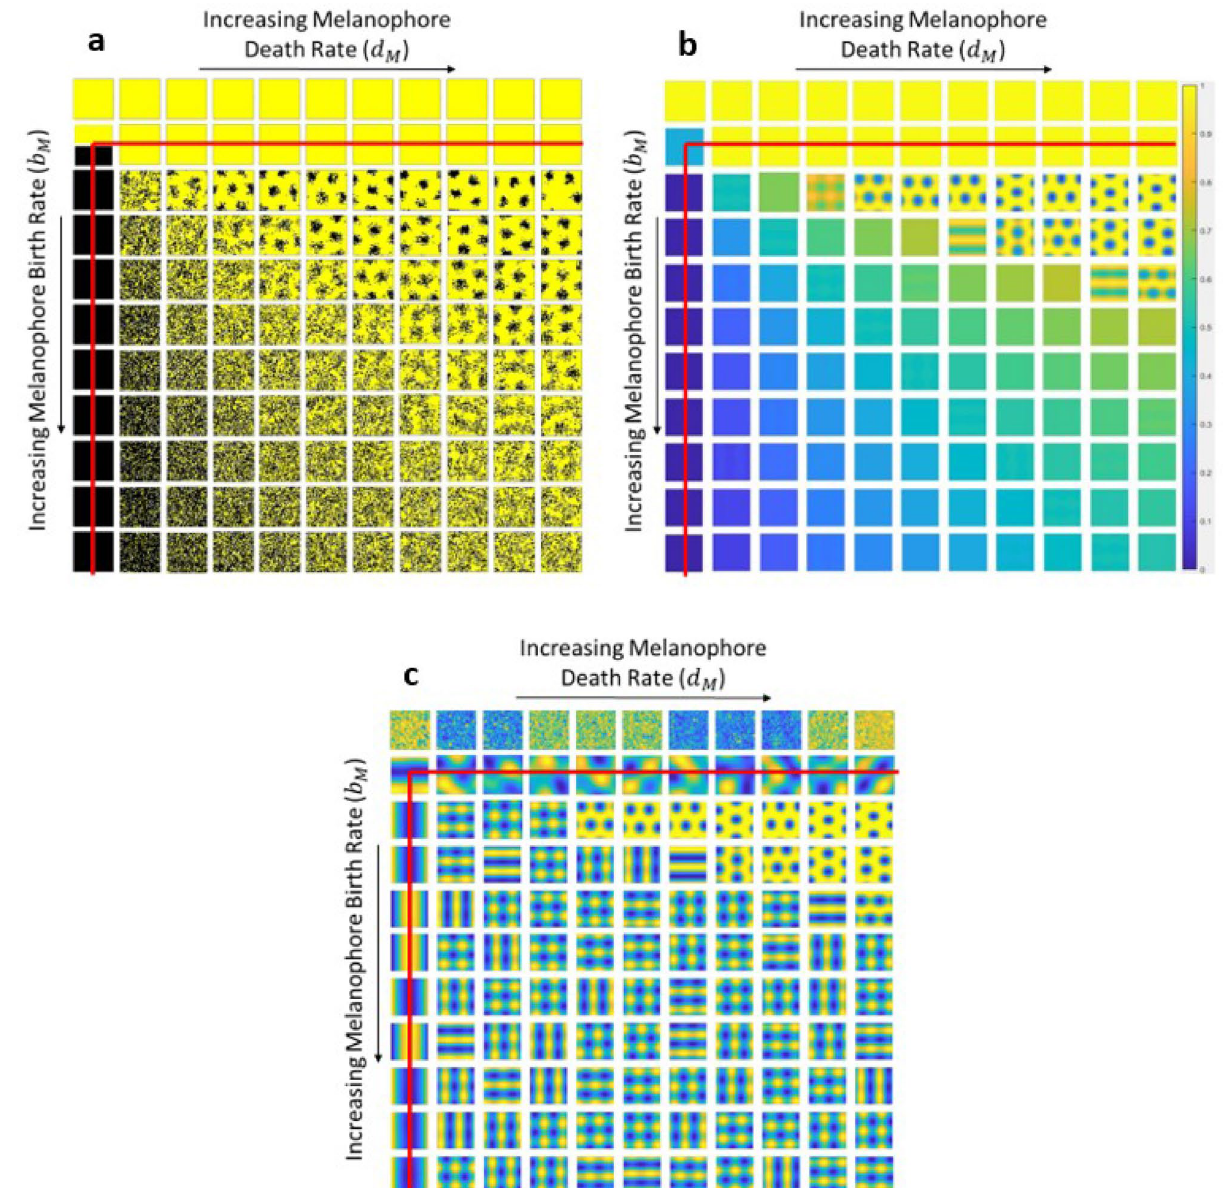
Figure 3. Numerical simulations of the Survival model on a two-dimensional 50 × 50 lattice with periodic boundary conditions. In all figures, b M and d M were varied from 0 to 10 (top to bottom and left to right, respectively). The following parameters were held constant: h = 15 , b X = s = 1 , d X = d MX = 0 . The red lines indicate the area where Turing patterns are predicted by the LSA. ( a ) Stochastic Monte Carlo simulations. Each simulation began on a uniform initial condition corresponding to an empty lattice. Yellow, black, and white lattice sites represent xanthophores, melanophores, and empty sites respectively. ( b ) and ( c ) Numerical integration of the two dimensional mean field equations describing the Survival model. Each simulation started from random initial conditions and ran for 1000 time steps. ( b ) shows the normalized concentration of xanthophores ( (cid:31) X i , j (cid:30) ) scaled absolutely between zero and one. ( c ) shows the same simulations scaled relative to each simulation’s maximum and